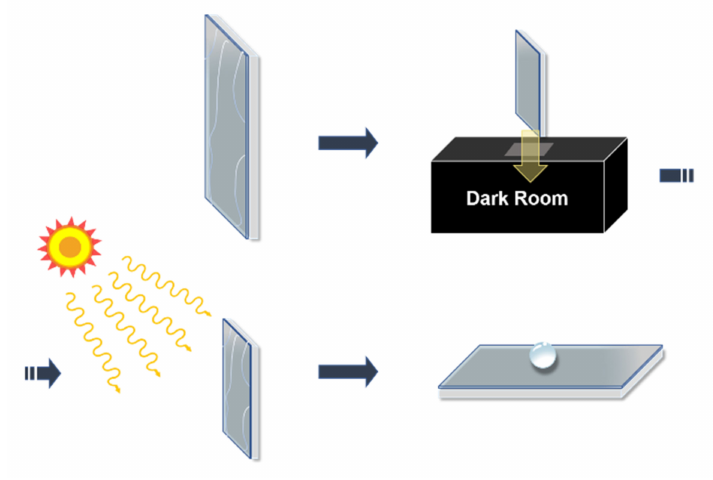
Figure 11. Schematic illustrating the procedure of the sustainability evaluation.